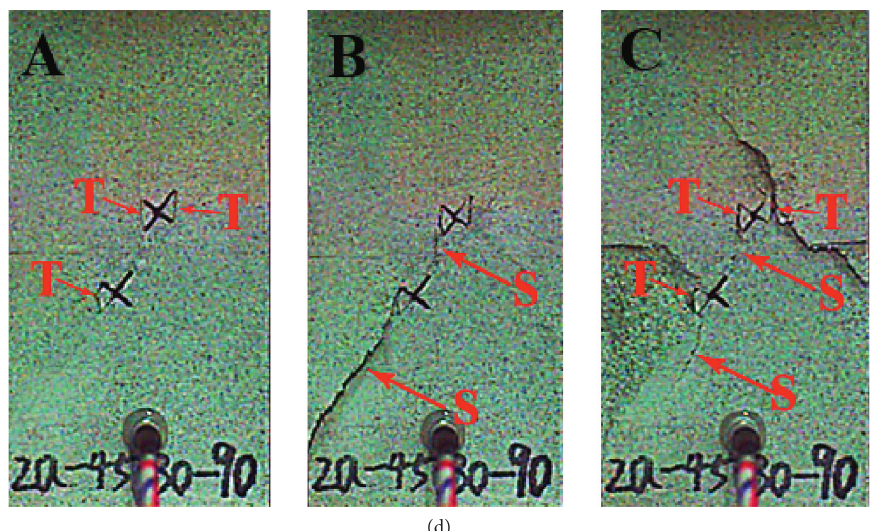
Figure 6: Crack propagation in specimens for different angles between main and minor flaws ((T) tensile crack, (S) shear crack, and (T-S) mixed tensile-shear crack). (a) c � 0 ° . (b) c � 30 ° . (c) c � 75 ° . (d) c � 90 °